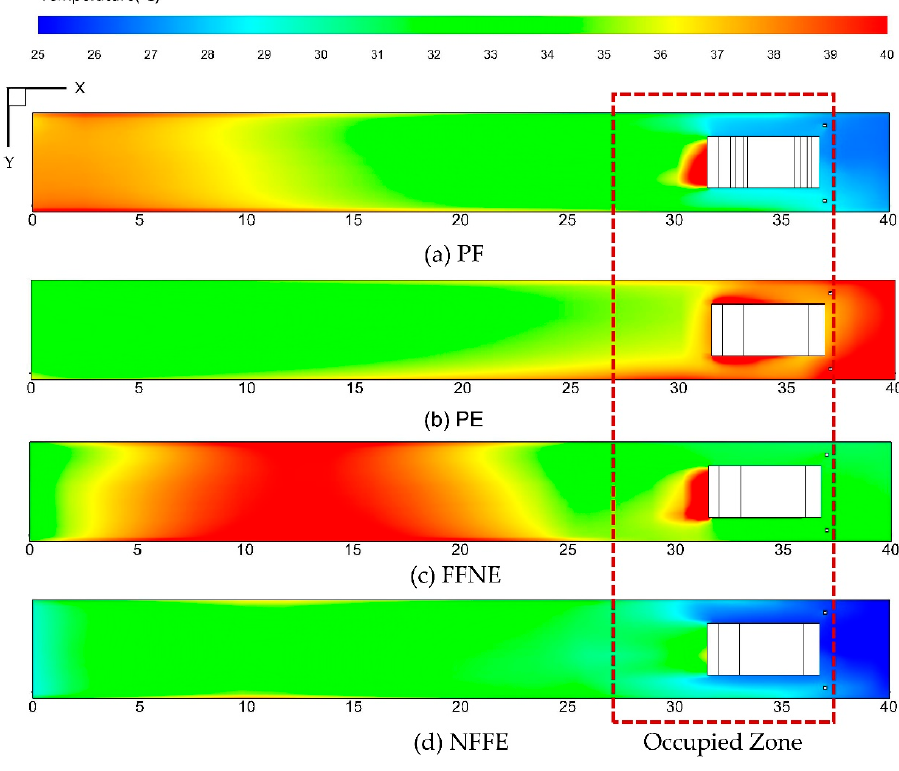
Figure 21. Airflow temperature distributions of the four auxiliary ventilation systems.